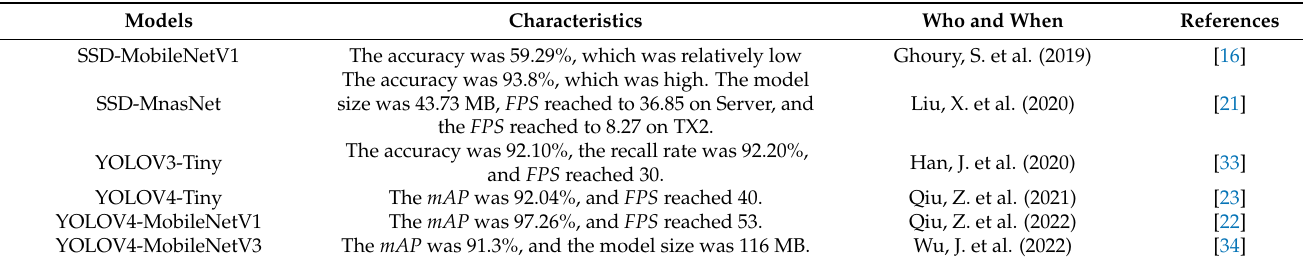
Table A1. Summary of mainstream lightweight models and their